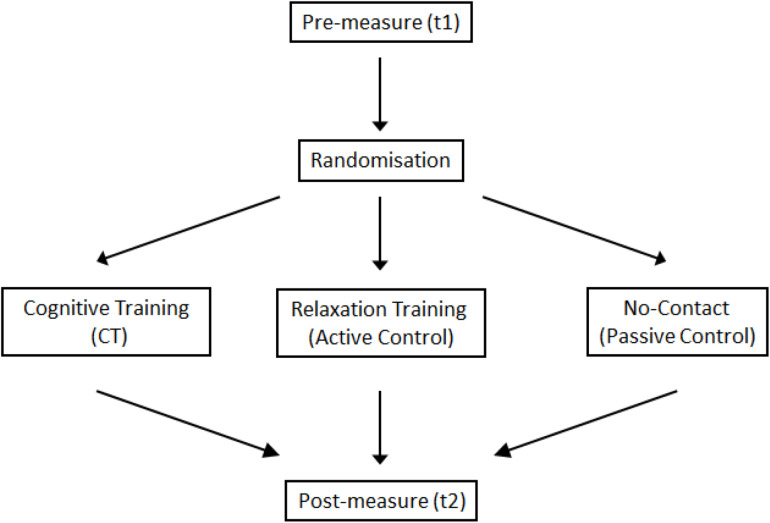
Design of the study.